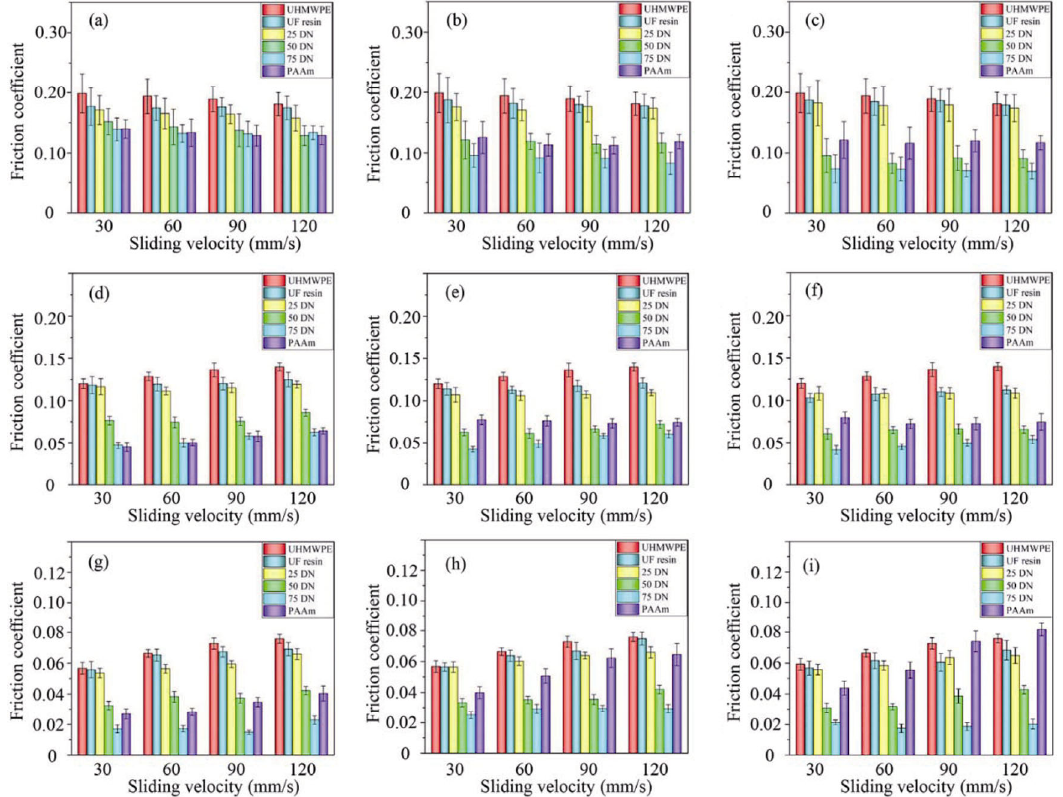
Fig. 6 Friction coefficients of UHMWPE and composites under different loads and microsphere contents: (a–c) 1 N, (d–f) 5 N, and (g–i) 10 N; (a, d, g) 1 wt% microsphere, (b, e, h) 3 wt% microsphere, and (c, f, i) 5 wt%